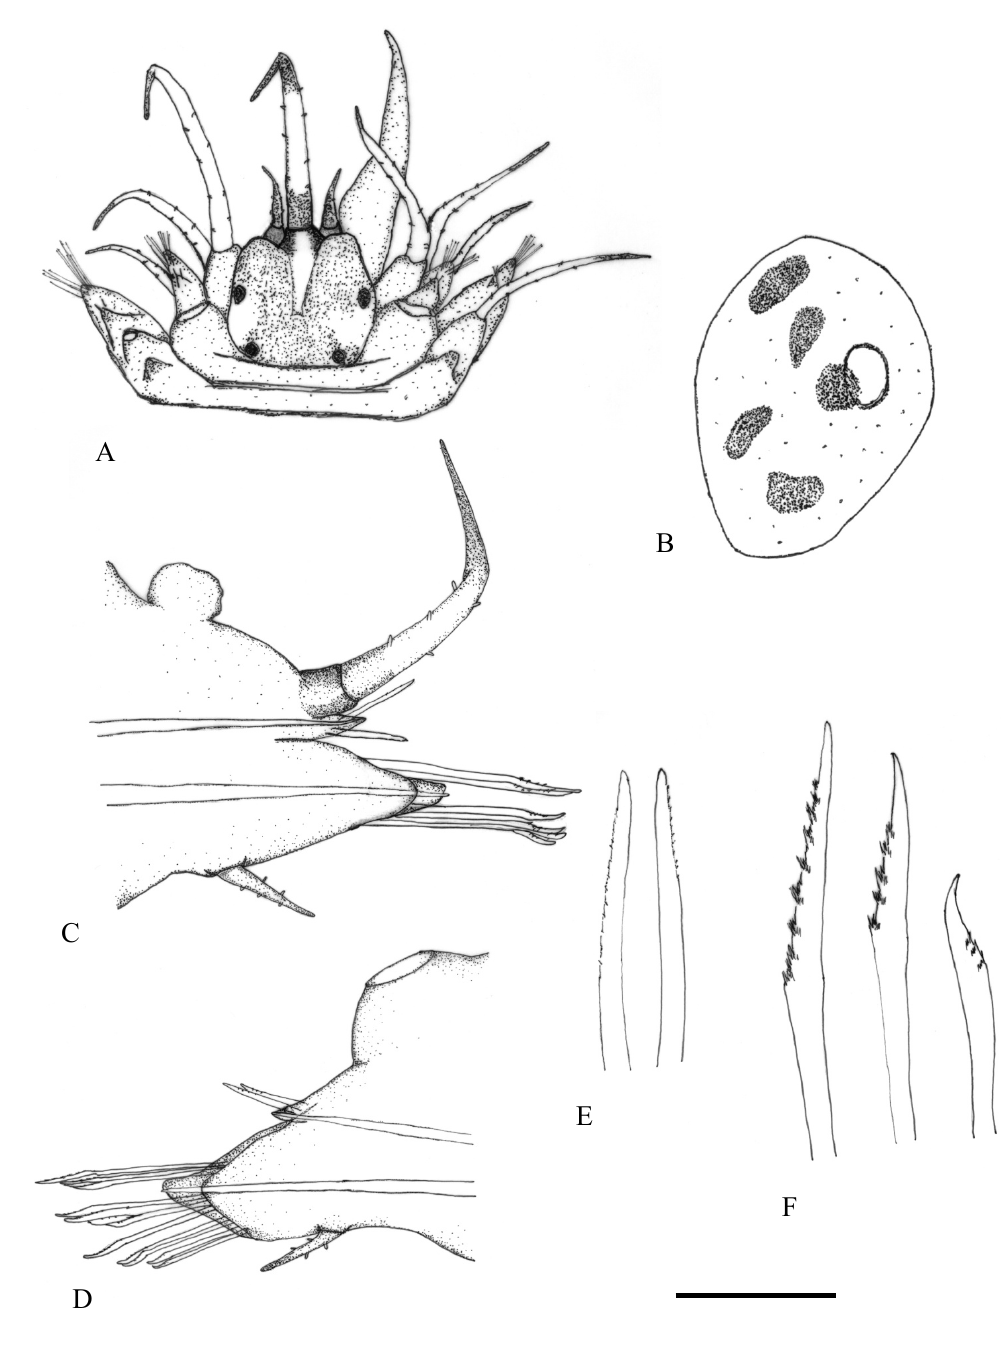
Fig. 2. Webbnesia maculata gen. et sp. nov., holotype (TFMCBM-AN/246). A . Anterior end, elytra removed and left dorsal cirrus of segment 3 missing. B . Right elytron of segment 21. C . Right cirrigerous parapodium of segment 20, posterior view. D . Left elytragerous parapodium of segment 21, posterior view. E . Notochaetae. F . Upper, middle and lower neurochaetae. Scale bar: A= 1.3 mm; B = 1.9 mm; C–D = 0.4 mm; E–F = 40